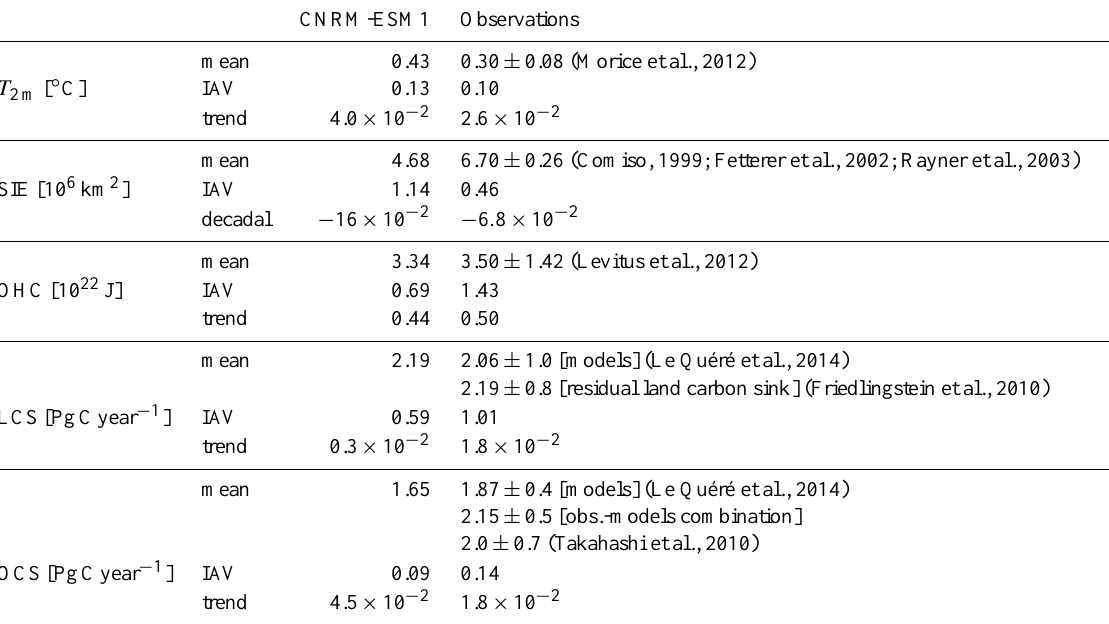
Table 3. Modern mean-state, interannual variability (IAV) and decadal trends of various global climate indices: the near-surface temperature ( T 2m ) , Arctic September sea-ice extent (SIE), 0–2000m ocean heat content (OHC) as well as the land and ocean carbon sinks (LCS and OCS, respectively). For LCS and OCS, positive values indicate an uptake of CO 2 by land and ocean. All metrics are computed over the 1986–2005 period for both model and observations. Decadal trends are estimated from linear regression over the 1986–2005 period. IAV is estimated from the standard deviation of the detrended time